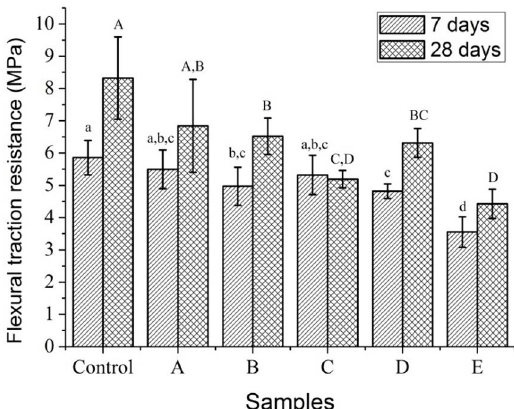
Figure 7. Results of tensile strength in flexion of mortar samples obtained with different proportions of the residue, in the hardened state at 7 and 28 days.